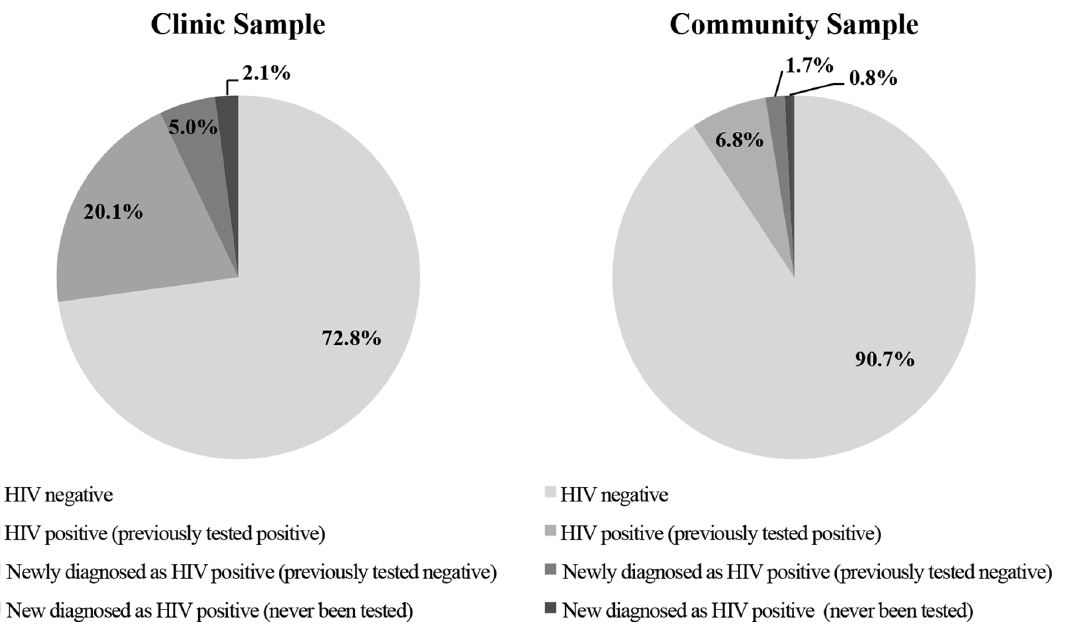
Figure 1. Distribution of HIV Testing History for all MSM from the Clinic (n=438) and Community-Based Sample (n=122); Lima, Peru 2007.